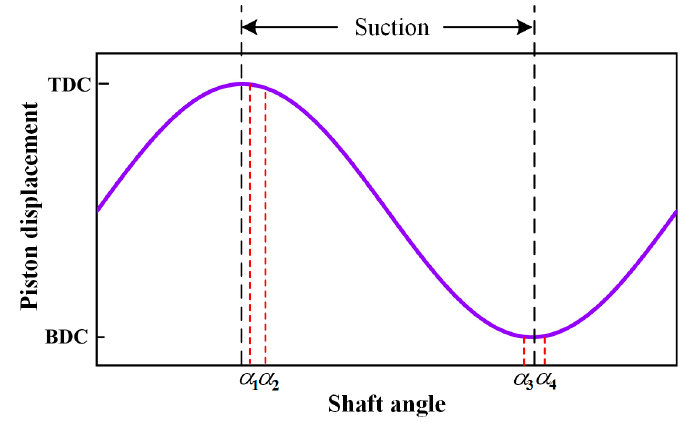
Figure 8. The diagram of the inspection angles of flow distribution.